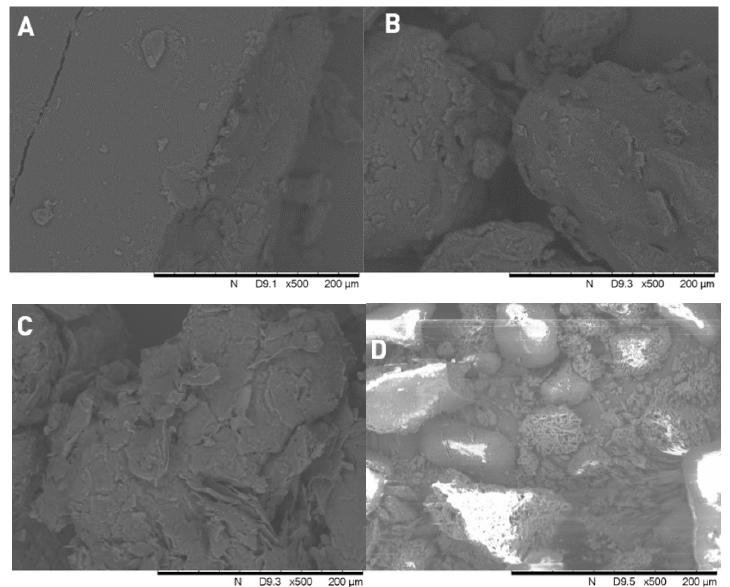
Figure 4. Scanning electron microscope images of PEG 2000 ( A ), PEG 1500 ( B ), PEG 1000 ( C ), and crystalline ketoprofen ( D ).